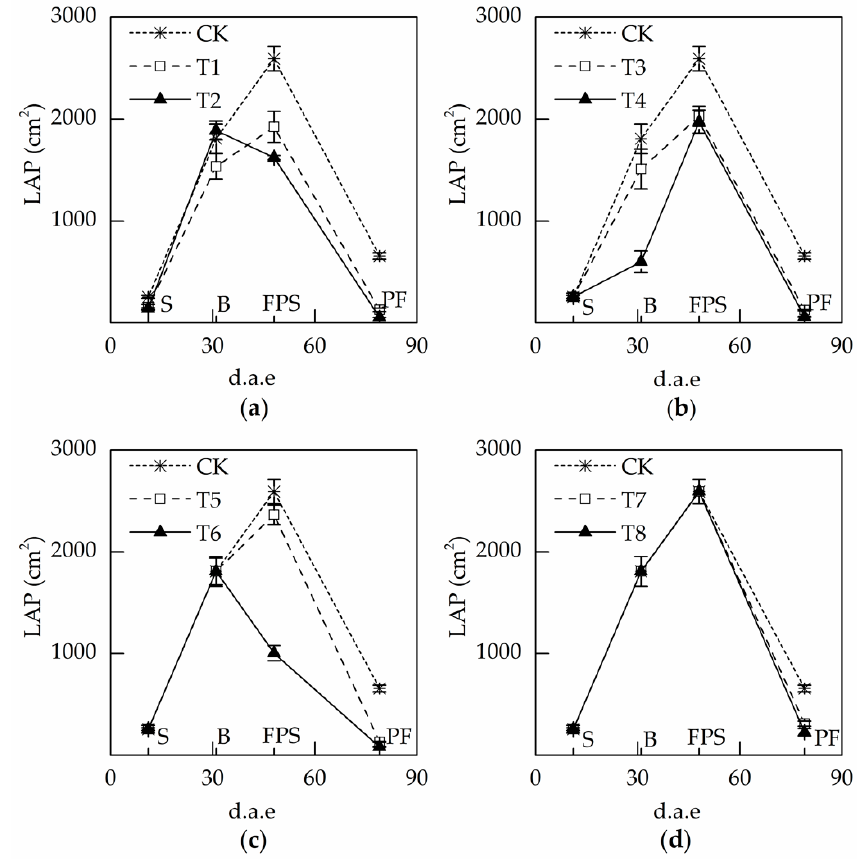
Figure 3. Leaf area per plant (LAP) of soybean during different growth stages under water stress in 2015: ( a – d ) the treatments with drought stress during seedling, branching, flowering and pod-setting stage, and pod-filling stage. S, seedling stage; B, branching stage; FPS, flowering and pod-setting stage; PF, pod-filling stage; d.a.e, day after emergence. Values were averaged from five samples.